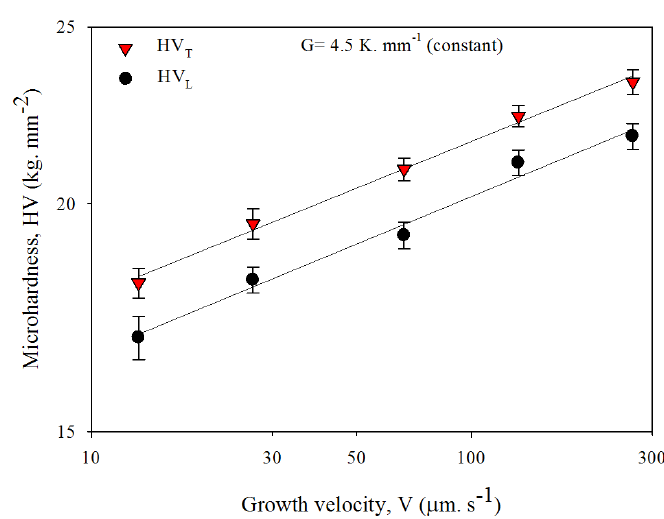
Figure 6. The variation of microhardness with growth velocity at a constant temperature gradient